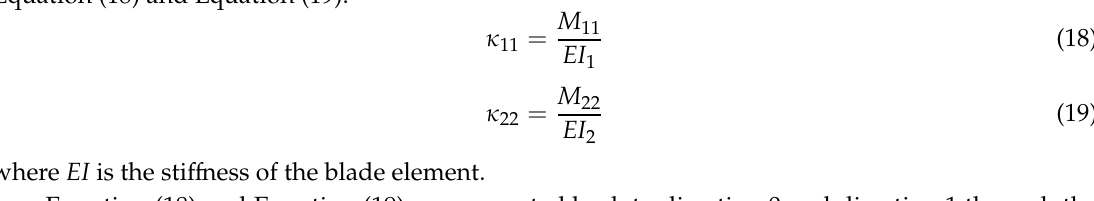
Figure 4. The blade element in the local coordinate system.